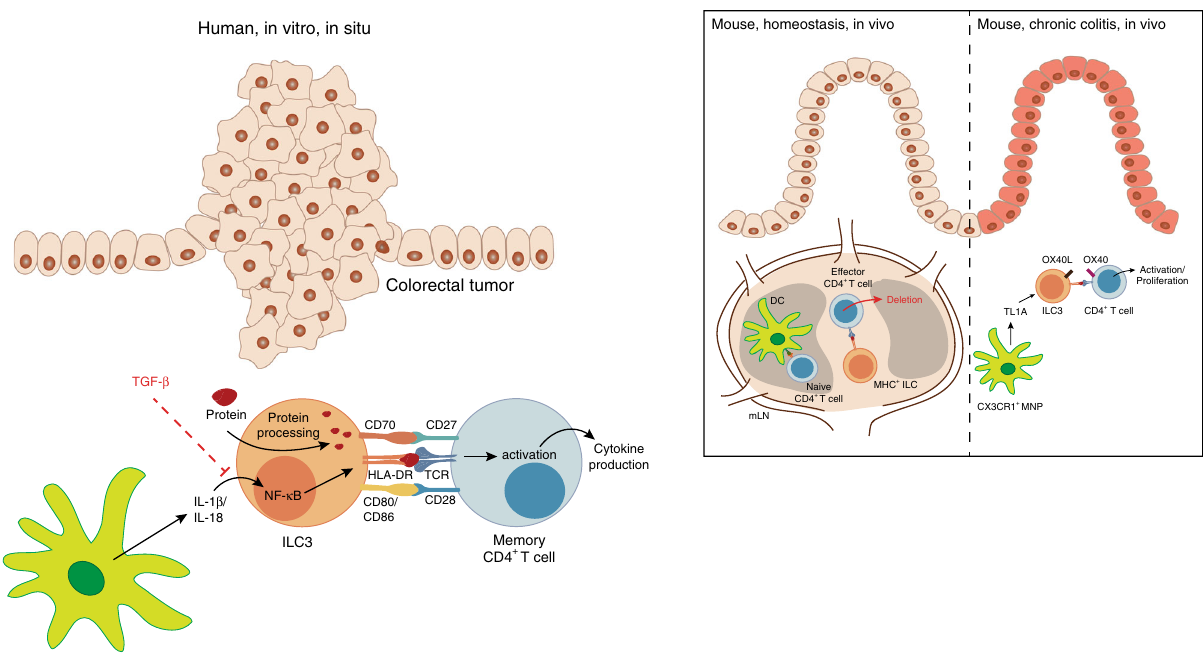
Fig. 8 Proposed model: the role of ILC3 in regulation of intestinal CD4 + T-cell responses. While it is known that naive CD4 + T cells are primed in mesenteric lymph nodes (mLN), several studies demonstrated ILC3-based regulation of effector CD4 + T-cell responses in mice. MHCII + ILC3 were shown to accumulate between T- and B-cell zones in mouse mLNs, co-localizing with emigrating commensal bacteria-speci fi c effector CD4 + T cells and perpetrating the depletion of the latter 20, 21 . In the setting of experimental chronic colitis, TNF-like ligand 1A (TL1A) produced by mononuclear phagocytes (MNPs) was observed to induce OX40L expression on ILC3, which in turn promoted T-cell activation and immunopathology 23 . In the present study we show that ILCs in human colorectal tumors display increased HLA-DR expression and co-localize with T cells in situ. Further in vitro analysis revealed that the in fl ammasome-associated cytokines IL-1 β and IL-18 could drive the expression of HLA-DR and co-stimulatory molecules on PB ILCs in an NF- κ B- dependent manner, while TGF- β potently inhibited these antigen-presenting properties. IL-1 β - and IL-18-activated ILCs were able to induce memory CD4 + T-cell responses in an autologous co-culture system following the uptake of full protein antigen. Hence, we would like to propose that cytokines present in the human colorectal tumor microenvironment might be able to modulate the antigen-presenting properties of intestinal ILCs with potential consequences for anti-tumor immune